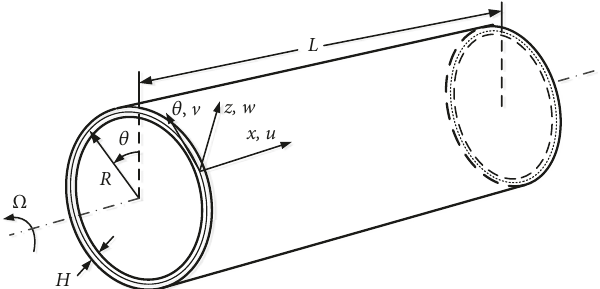
Figure 1: Geometry and coordinates of a thin rotating cylindrical